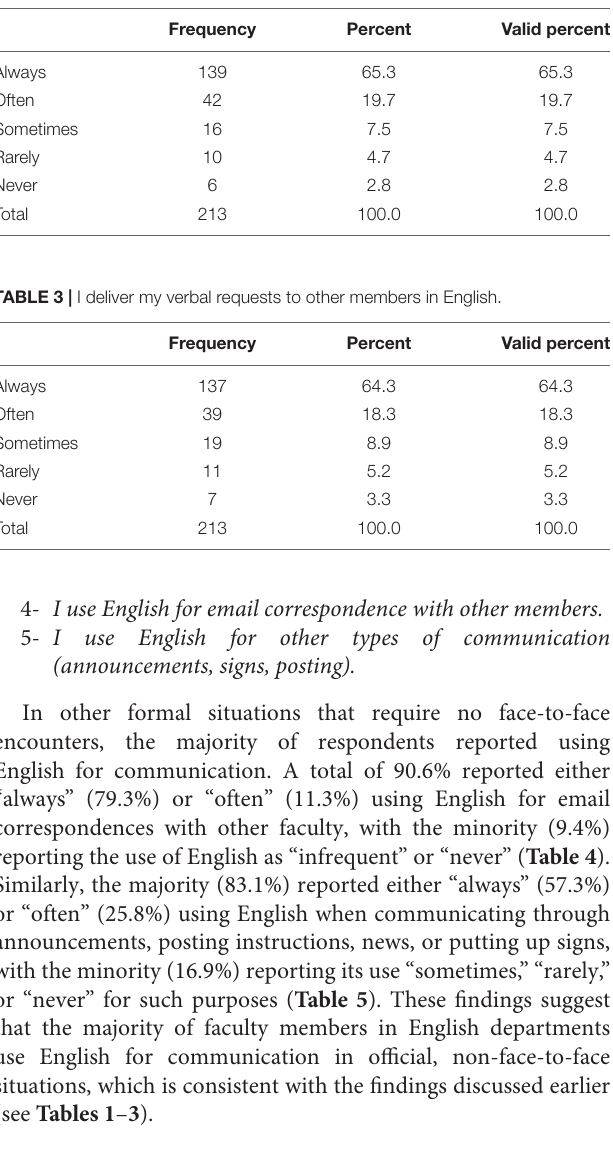
TABLE 2 | I use English for communication during committee meetings.